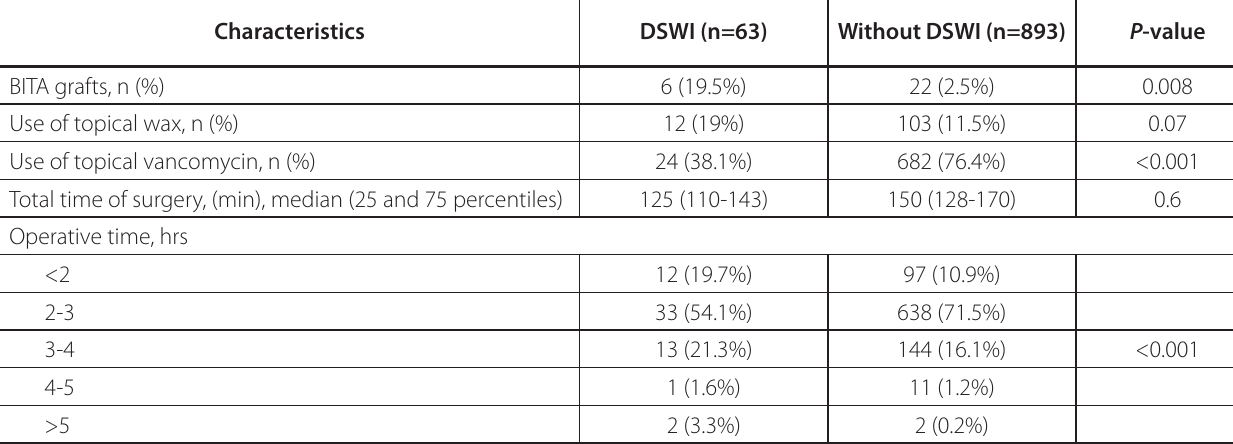
Table 2 . Perioperative risk factor for sternal infection.